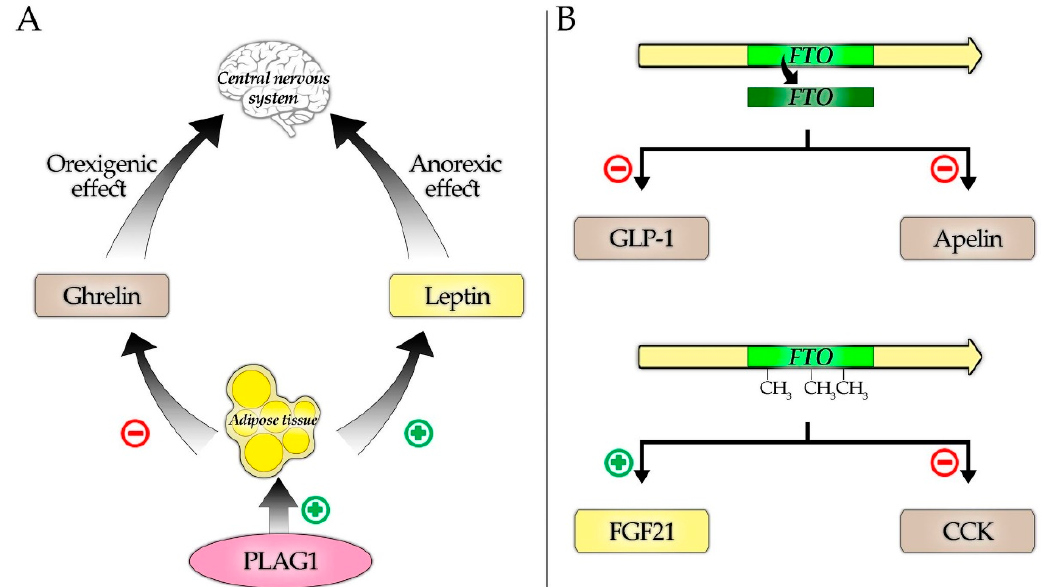
Figure 1. Suggested mechanisms of interactions between the studied genes and hormones. ( A ) Regulation of ghrelin and leptin, key appetite and satiety controlling hormones by PLAG1 , secondary to its fat tissue stimulating properties. ( B ) Selected hormones downregulated in response to the increased FTO expression (upper part) and influenced by the higher FTO methylation (down